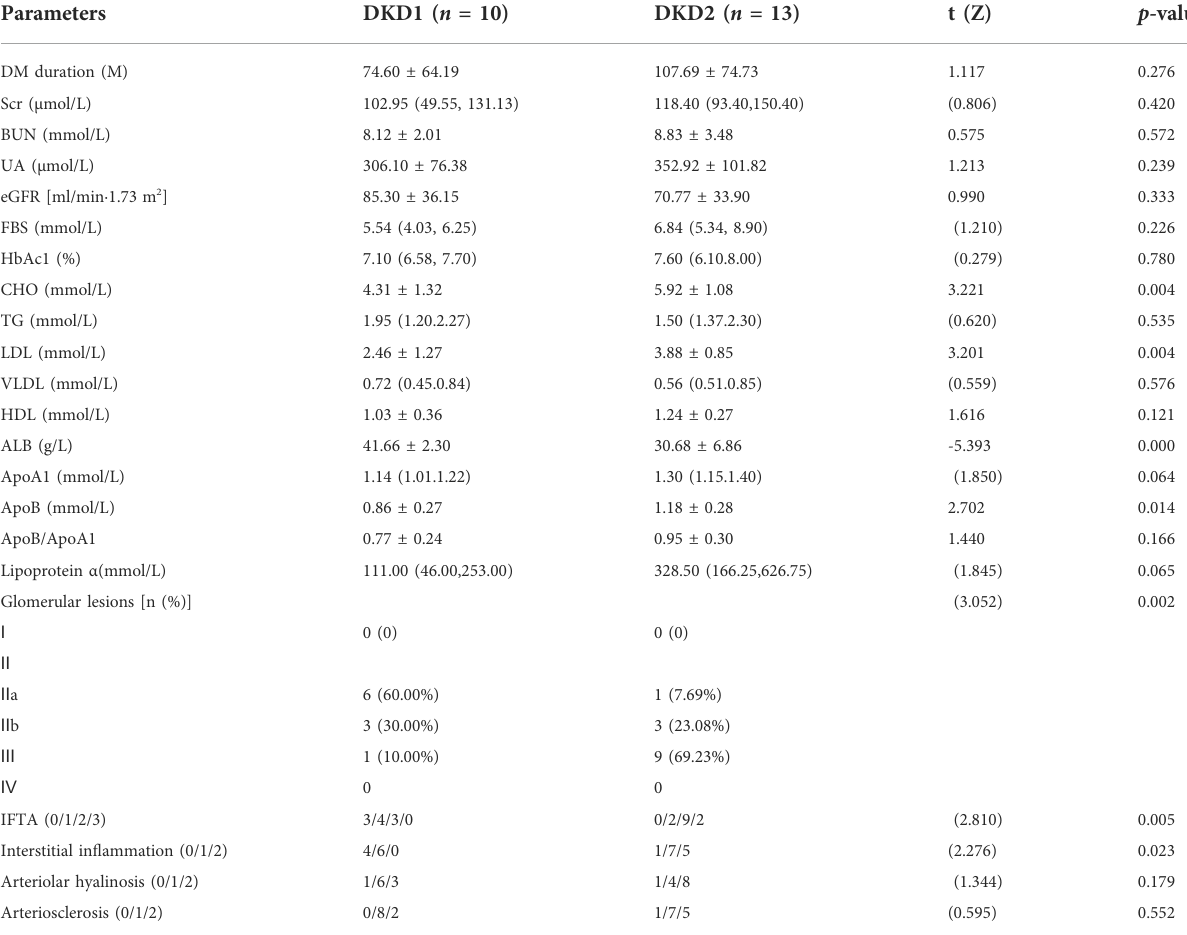
TABLE 3 The clinical and pathological characters of DKD patients.